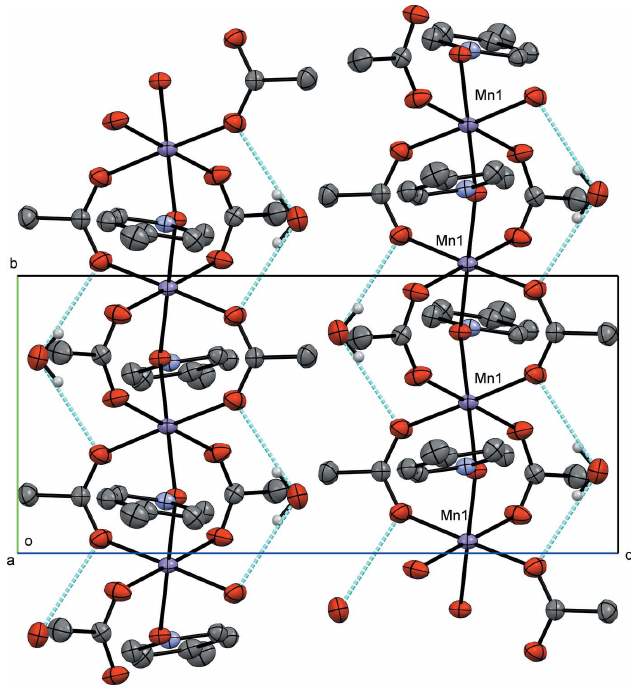
Figure 6 Crystal packing diagram of compound III , viewed along the a axis. H atoms not involved in hydrogen bonding have been omitted for clarity, hydrogen bonds are rendered in